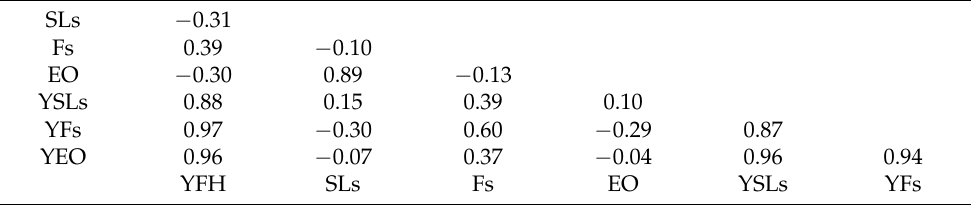
Figure 6. Principal component analysis (PCA) ordination diagram presenting the distribution of the samples based on mean values of the studied characteristics under the influence of ni- trogen fertilization; E—eigenvalues, V—percentage variance explained by the first two PCA axes, SLs—sesquiterpene lactones, Fs—flavonoids, EO—essential oils, YSLs—yield of sesquiter- pene lactones, YFs—yield of flavonoids, YEO—yield of essential oils, YFH—yield of flower heads, 0 N–120 N—nitrogen doses, circle—loamy soil, triangle—sandy soil, red color—2017, blue color—2018, green color—2019. Table 4. Correlation coefficients for relationships between the studied traits of plants from the sandy soil during the three-year experiment ( n = 24); bolded correlation coefficients are statistically significant. For explanations, see Figure 5.